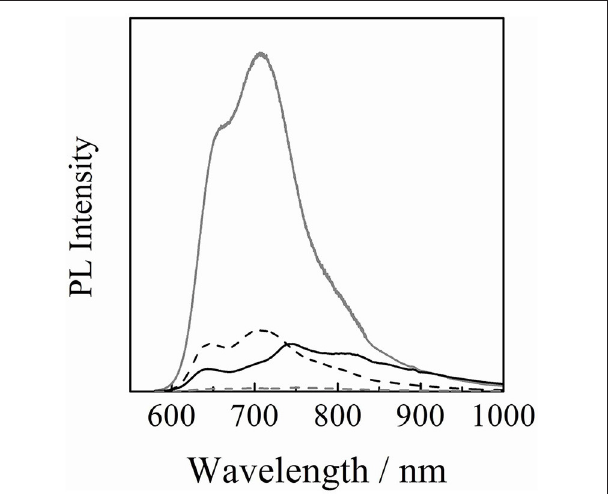
FIGURE 5 | PL spectra of P3HT neat (gray line) and blend films with different compositions: P3HT/PCBM (20:20, w/w) (black broken line), P3HT/PCBM/PCDPP4T (20:20:1.4, w/w/w) (gray broken line), and P3HT/PCDPP4T (3:4, w/w) (black solid line) blend films. The PL intensity of P3HT was corrected for variation in the absorption at an excitation wavelength of 500nm. The PL intensity of PCDPP4T was corrected by subtracting the PL intensity due to the direct excitation of PCDPP4T at 500nm.